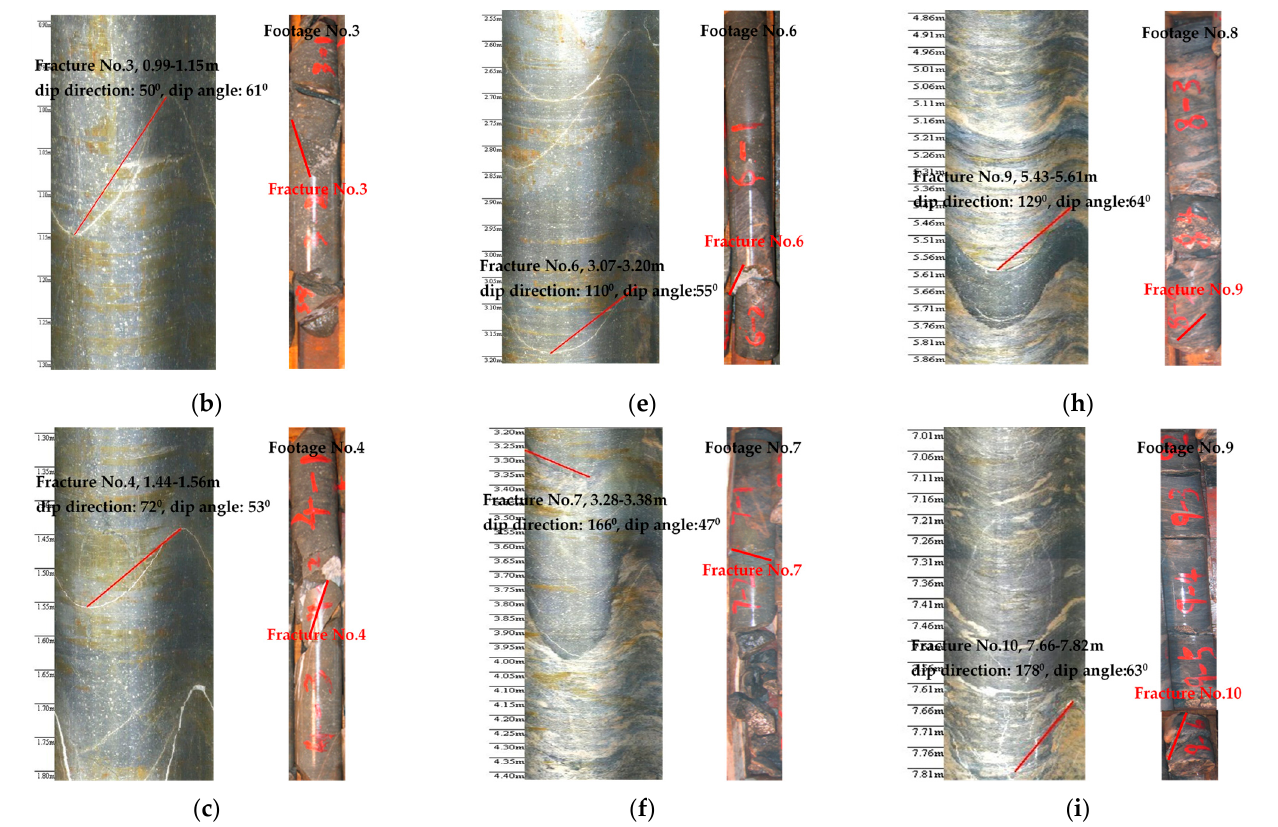
Figure 4. Each footage geological information photo obtained by the slug test system and the corresponding footage core photo. ( a – i ) corresponds to the different footage.